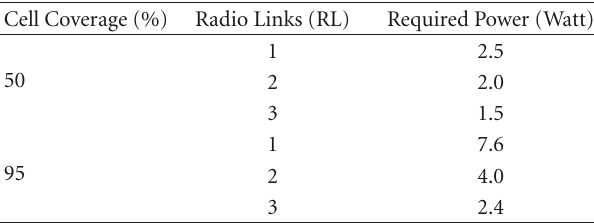
Table 4: Indicative FACH Tx power levels with macrodiversity combining.